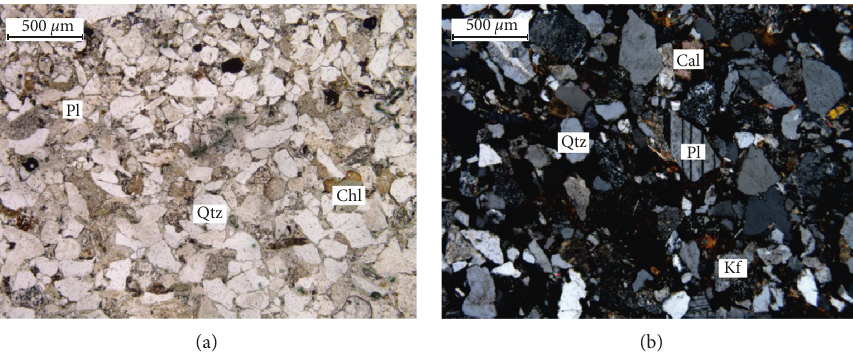
Figure 1: Microscopic structure by mineral composition and optical microscopy analysis: (a) plane-polarized light; (b) perpendicular polarized light. Table 1: Basic physical and mechanical properties of the sandstone.